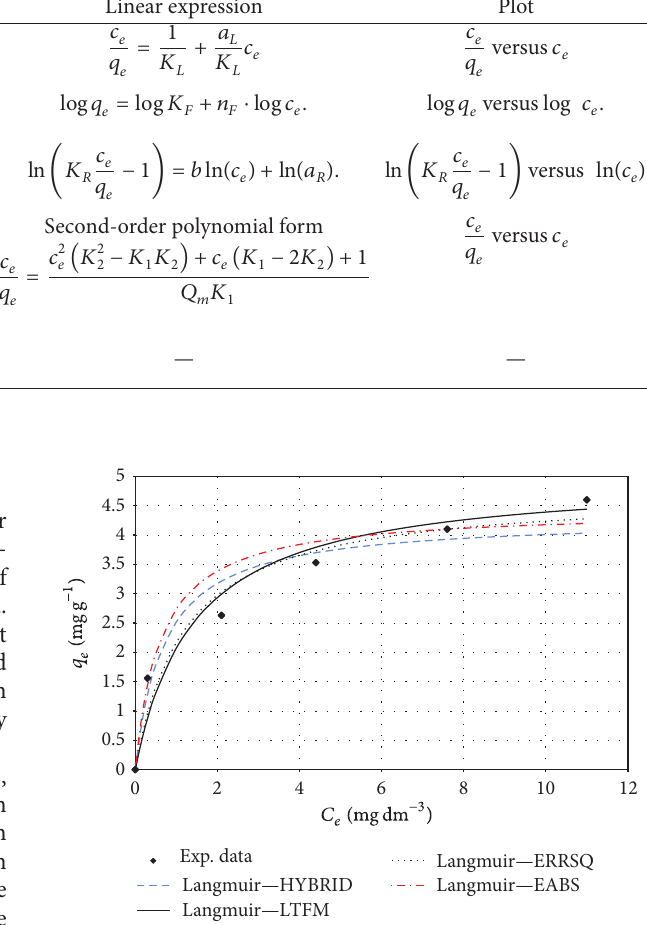
F 1: Experimental equilibrium data and Langmuir isotherms of p -NP biosorption on R. oryzae dead biomass